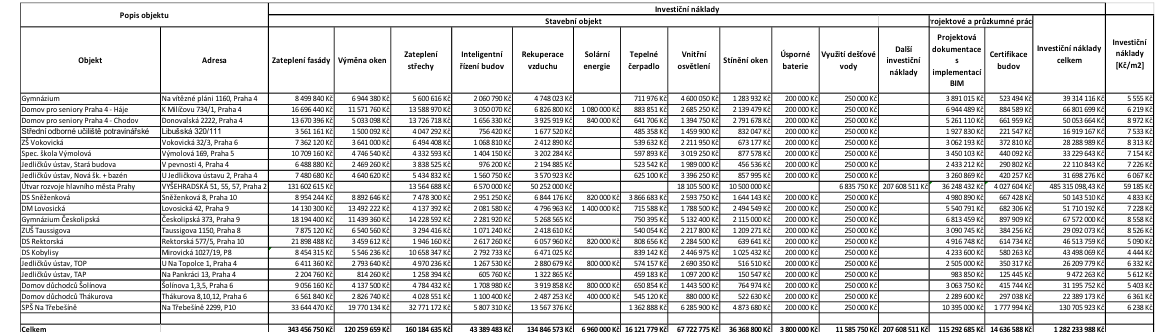
Tab 7: Předpokládané investiční náklady